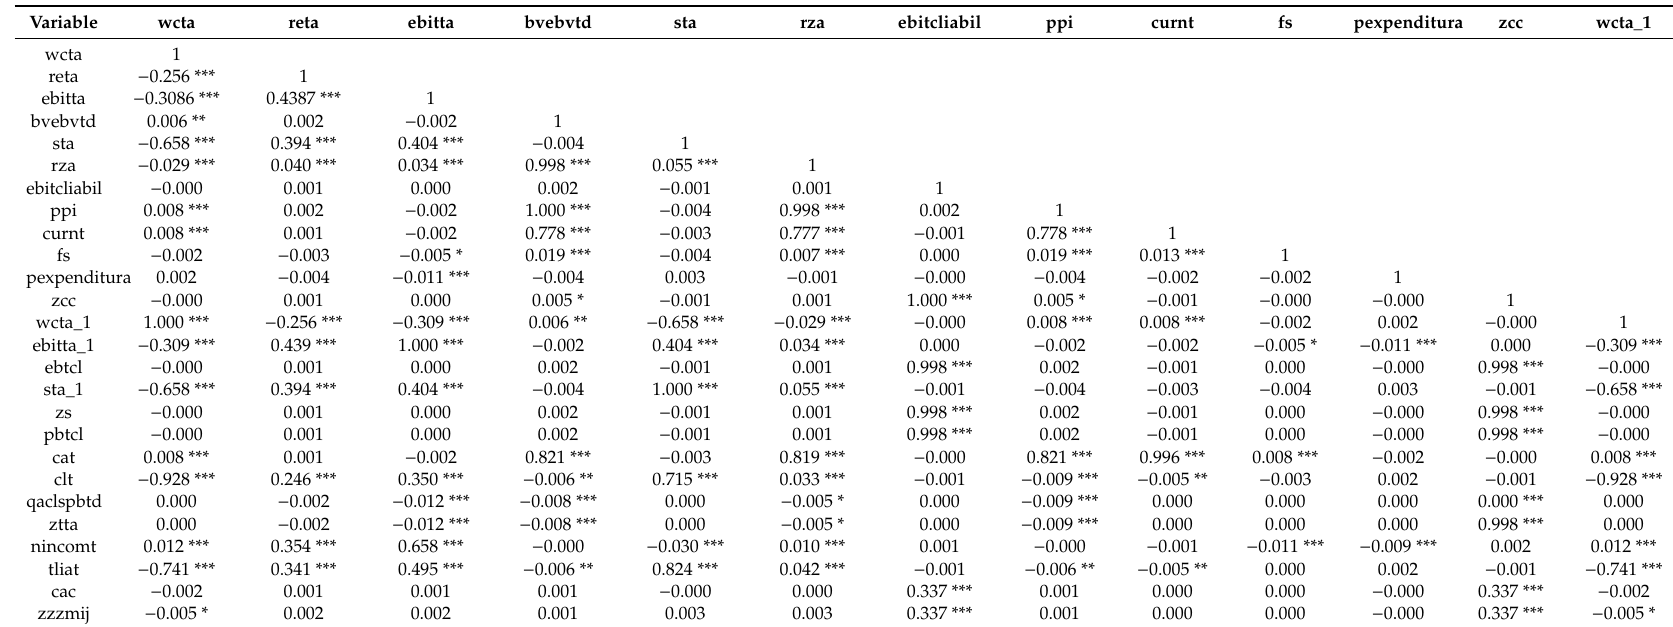
Table A1. Pearson Correlation